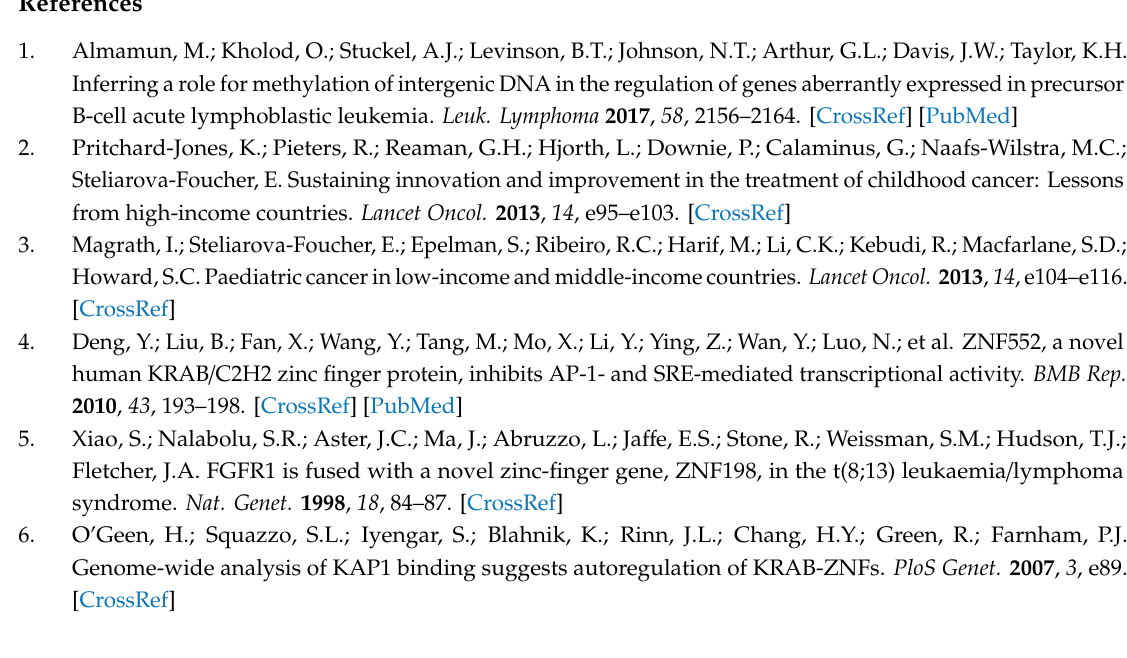
Figure S1: Representative sequence ZNF695_TV6, Figure S2: Representative sequence